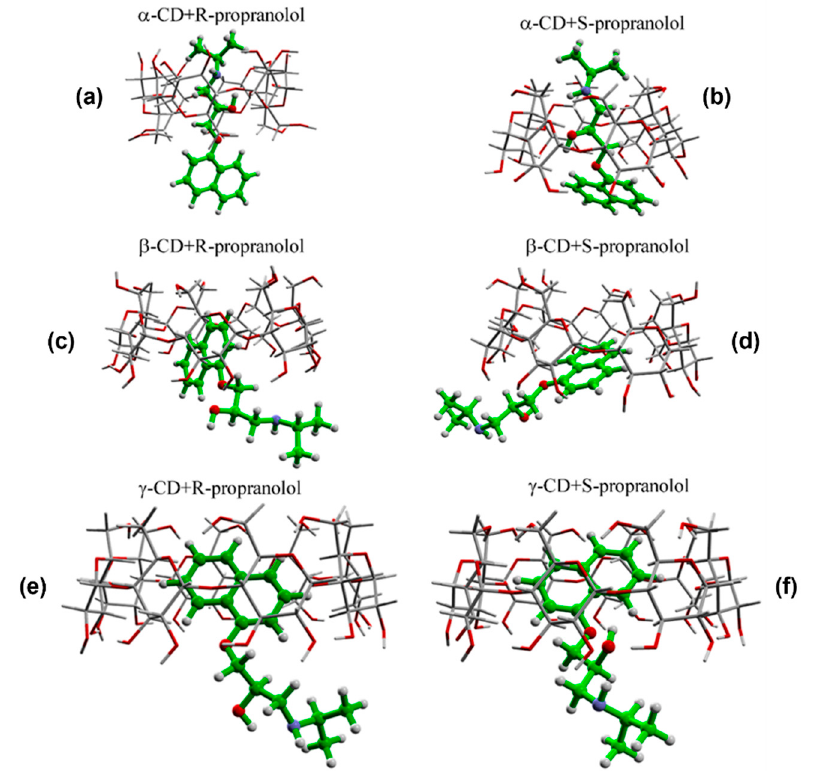
Figure 1. Calculated geometries of interactions of the six intermolecular complexes formed between PRNL and cyclodextrins: α -CD+R-propanolol ( a ), α -CD+S-propanolol ( b ), β -CD+R-propanolol ( c ), β -CD+S-propanolol ( d ), γ -CD+R-propanolol ( e ), γ -CD+S-propanolol ( f )